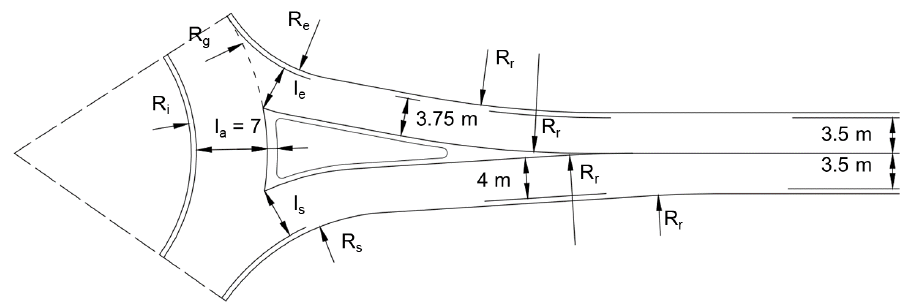
Figure 21. Right edge of the pavement at the roundabout entry and exit according to [5].